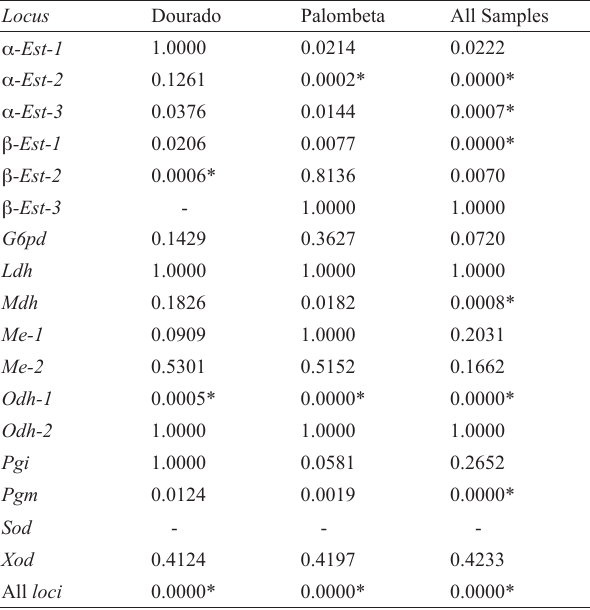
Tab. 4. Probability (P) of Hardy-Weinberg equilibrium (Ho: random union of gametes; *: significant before Bonferroni correction; α=0.0015625 for dourado and palombeta and α= 0.002777 for all